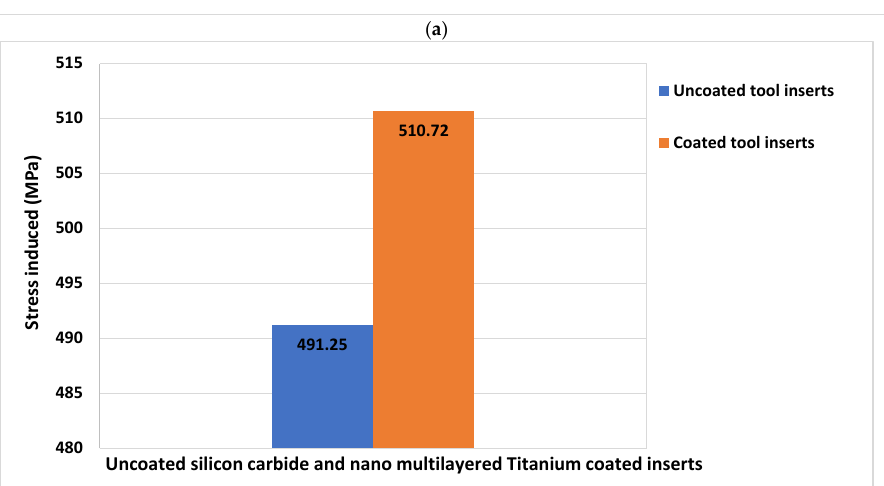
Figure 9. Microscopic images of uncoated and Nano multilayer TiN-coated Silicon Carbide tool in- serts. 4. Conclusions Titanium Nitride coating is suitable for machining of SS304 steels and machining characteristics of tool inserts are strongly influenced by the machining parameters such as feed, cutting speed and depth of cut. The vibrations of machine tools affect the quality of machining. The following deductions are performed in the turning tests and FEM results. 1. At a feed rate of 0.7 mm/min, a depth of cut 0.5 mm and a spindle speed of 250 rpm, 12 KHz of vibrational frequency is observed in the uncoated Silicon Carbide tool in- sert. Meanwhile, in the Titanium Nitride-coated tool insert, the vibration frequency is reduced to 10 KHz; 2. The vibration frequencies of SiC and TiN tool inserts show the increasing trend cor- responding to the feed rate, depth of cut and the cutting speed. The amplitude and